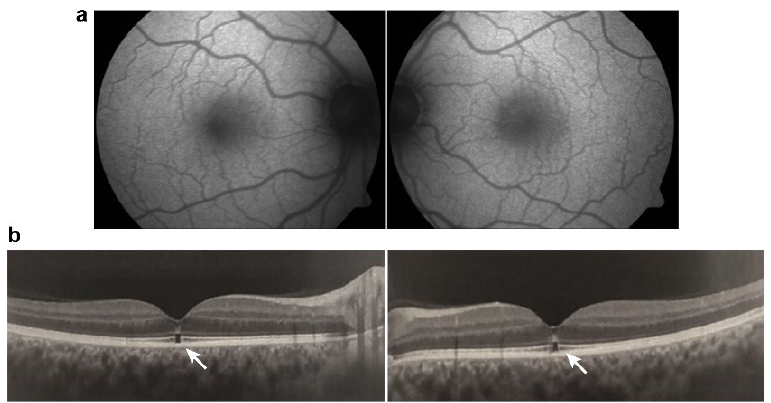
Figure 6. Tamoxifen retinopathy: ( a ) fundus autofluorescence image showing no abnormality; ( b ) optical coherence tomography: white arrow demonstrates ellipsoid foveal zone disruption and external limiting membrane hyperreflectivity.